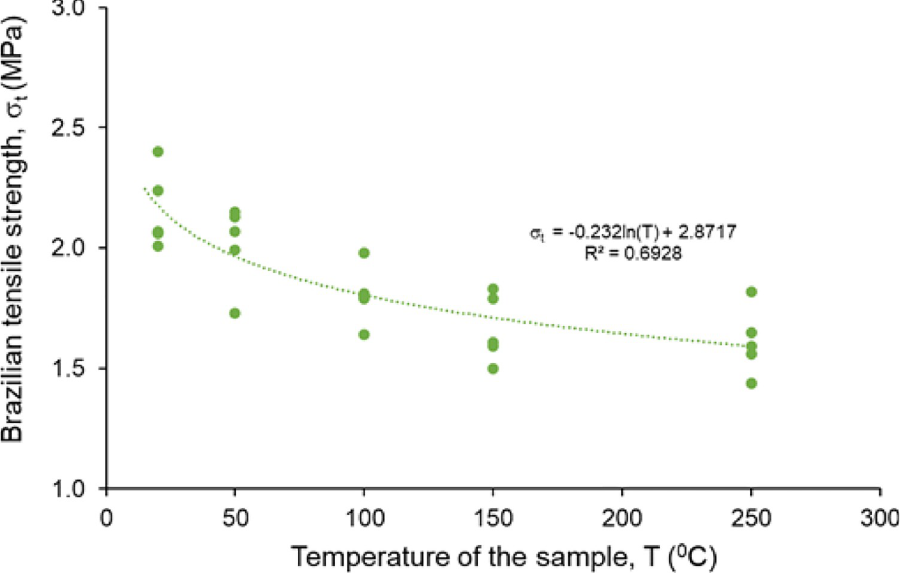
Fig 6. The variation of Brazilian tensile strength of C¸ankırı rock salt at different temperatures.